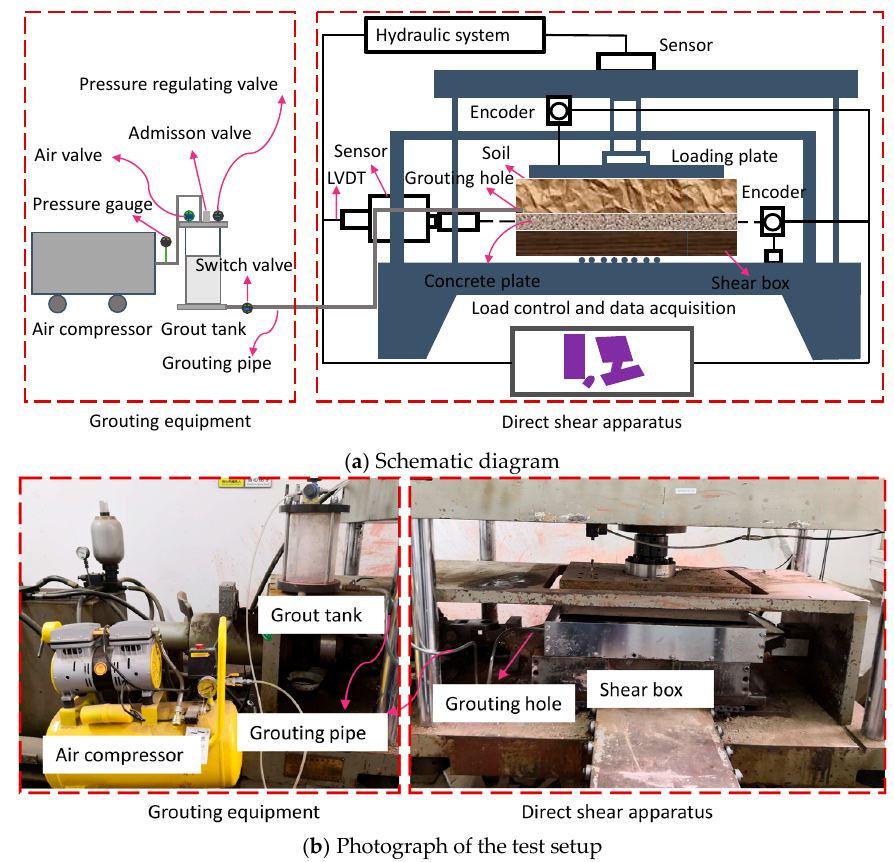
Figure 1. Apparatus for grouting and direct shear test: ( a ) schematic diagram and ( b ) photograph of the test setup.